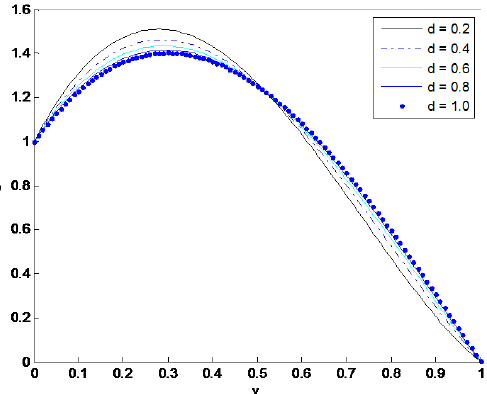
Figure 12: Velocity profile for different values of boundary thickness